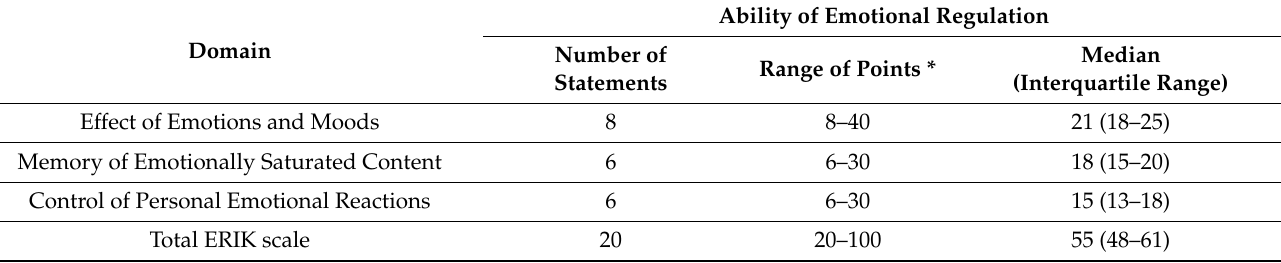
Table 4. Level of emotional regulation and control ability of respondents (N = 203).